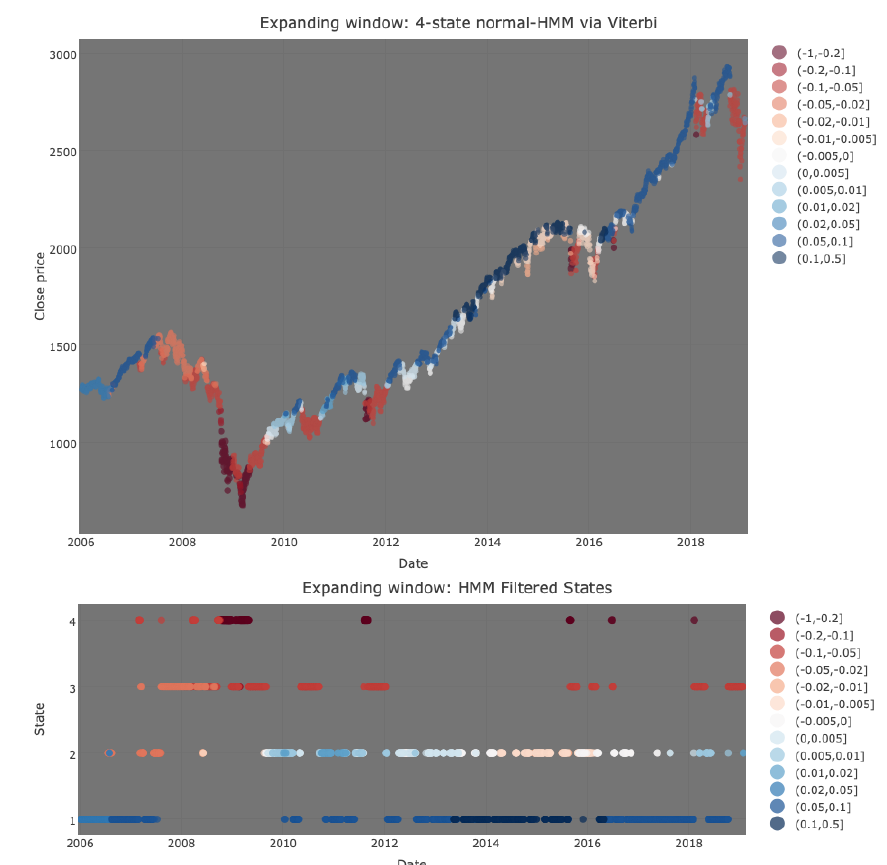
Figure 13. Expanding window: four-state normal HMM filtering via the Viterbi algorithm on the S and P 500 Index. Upper figure: Colours vary by the value of the state-dependent mean (see legend), and the larger the state-dependent volatility, the larger the dot size. Lower figure: The plot indicates the inferred state at each time-point, and the colour code also indicates the value of the state-dependent mean as per the legend. Figure reproduced from